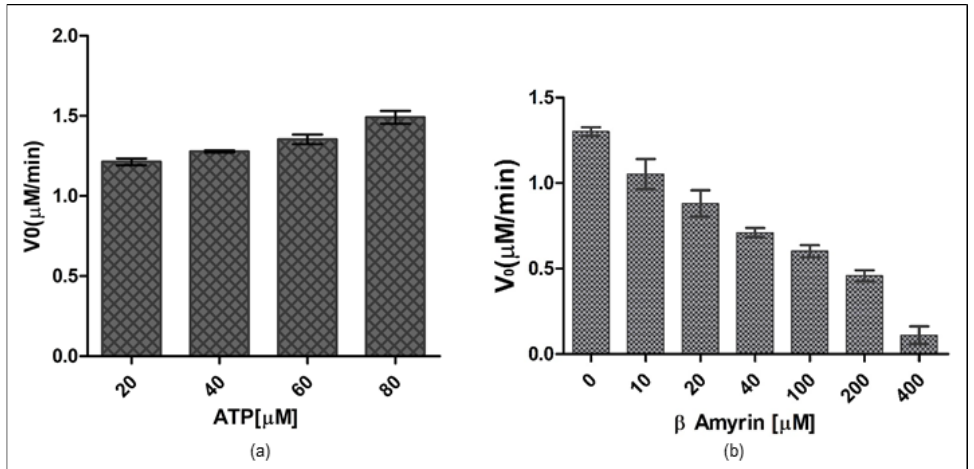
Figure 7. Biochemical characterization of Rv1636. ( a ) ATPase activity of Rv1636 determined by malachite green assay. The X and Y -axis show ATP concentration and enzymatic activity of Rv1636, respectively. ( b ) Effect of β -Amyrin on the ATPase activity of Rv1636. The X and Y -axis show beta-Amyrin concentration and enzymatic activity of Rv1636, respectively. The experiment was performed in triplicates, and S.D. was determined.